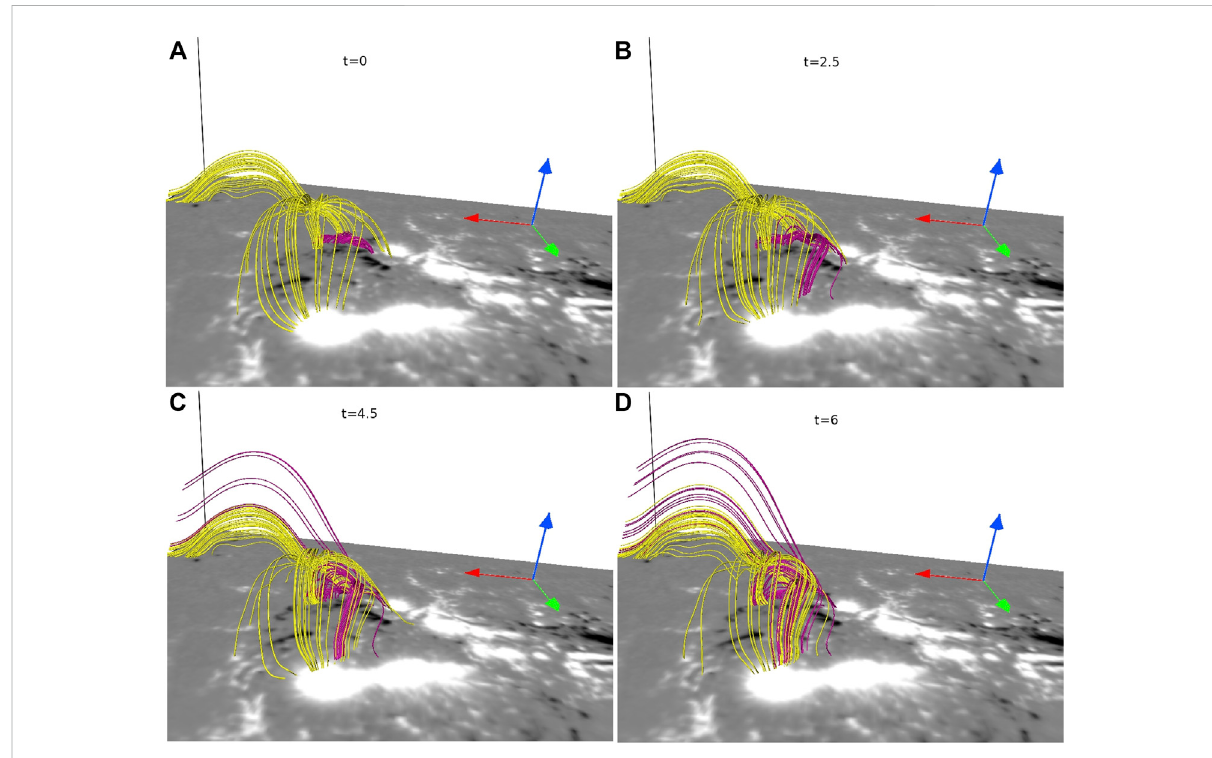
FIGURE 7 The fi gure depicts the evolution of the 3D null (in yellow) and the fl ux rope (in magenta). The time is shown in units of 3.2 τ a ≈ 1 min. The initial state isshown inpanel (A) . Theropelocatedbelow thedomerisesto the3Dnull [panel (B) ]andundergo magnetic reconnections [panels (C andD)